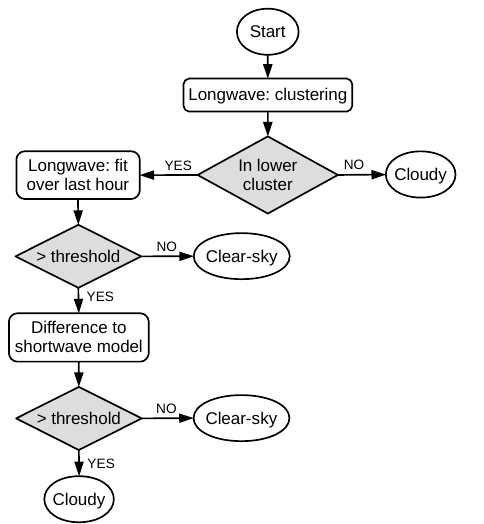
Figure 8. Cloud mask algorithm.